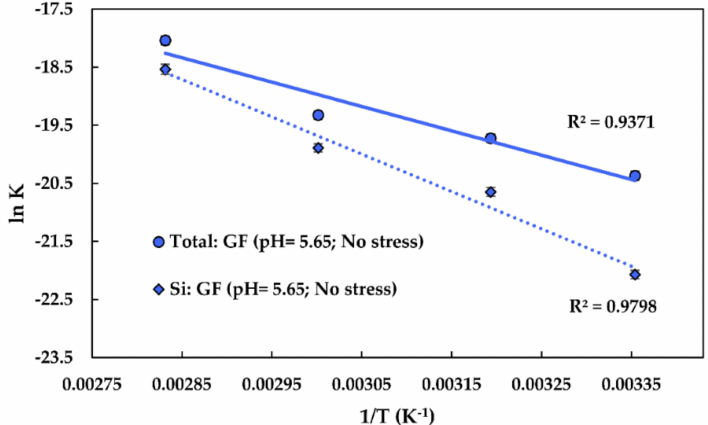
Figure 6. The graphing approach used to obtain the pre-exponential factors, the activation energies of Si, and the total glass dissolution of the fibres at a pH of 5.65 and under no stress. GF: Glass fibre. 1/T stands for reciprocal temperature; R 2 is the determination